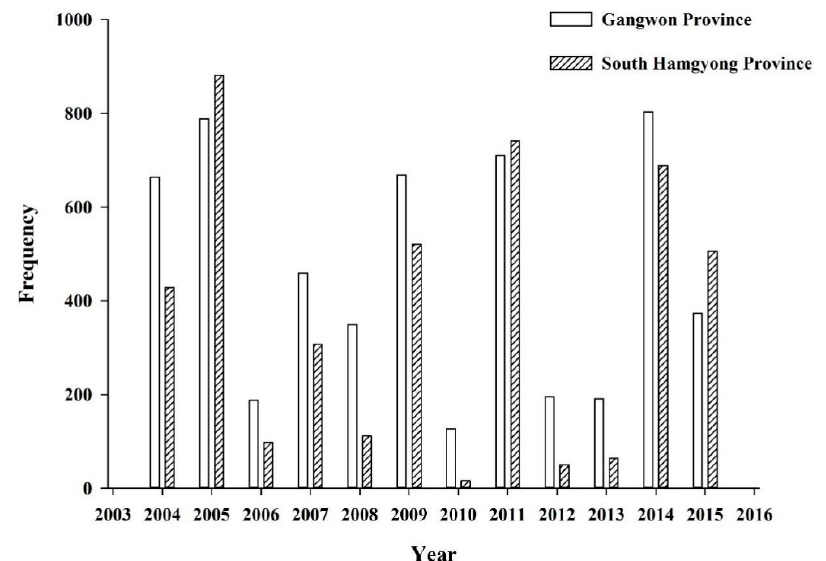
Figure 4. Number of hot spots derived from MODIS data from 2004 to 2015 in both study areas (Unit: frequency; Source: NASA FIRMS).